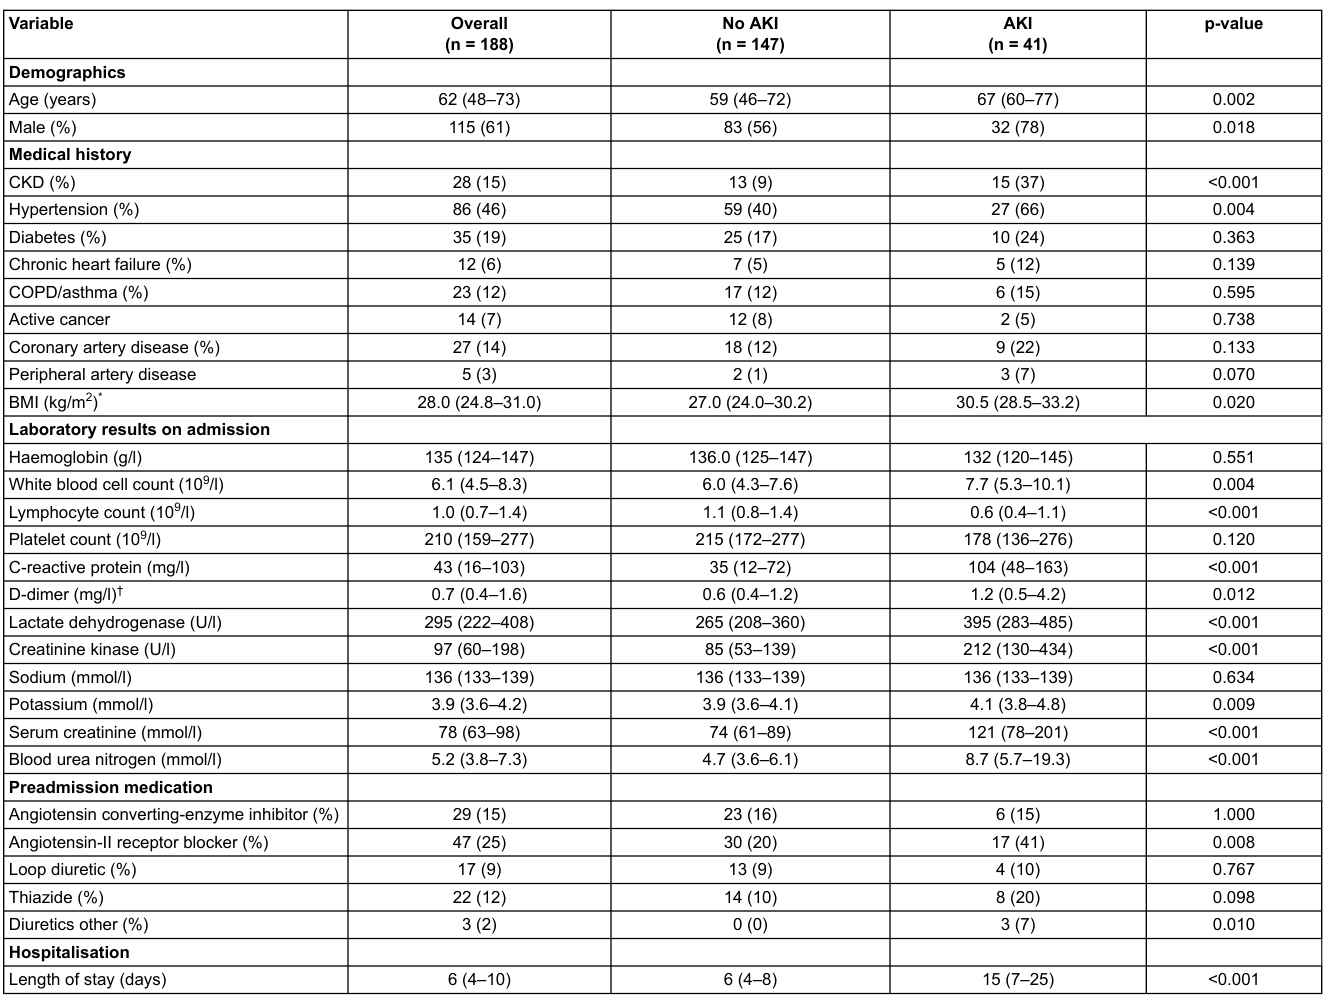
Table 1: Baseline